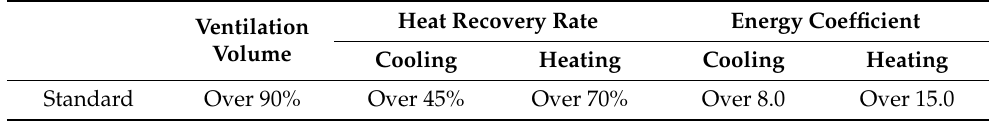
Table 2. Minimum standard of heat recovery ventilator based on KS B